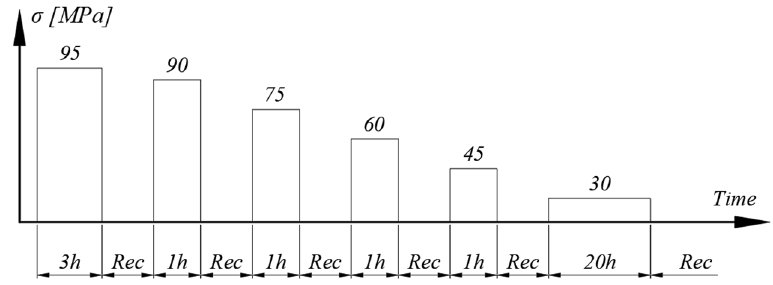
Figure 5. Creep-recovery with variable creep